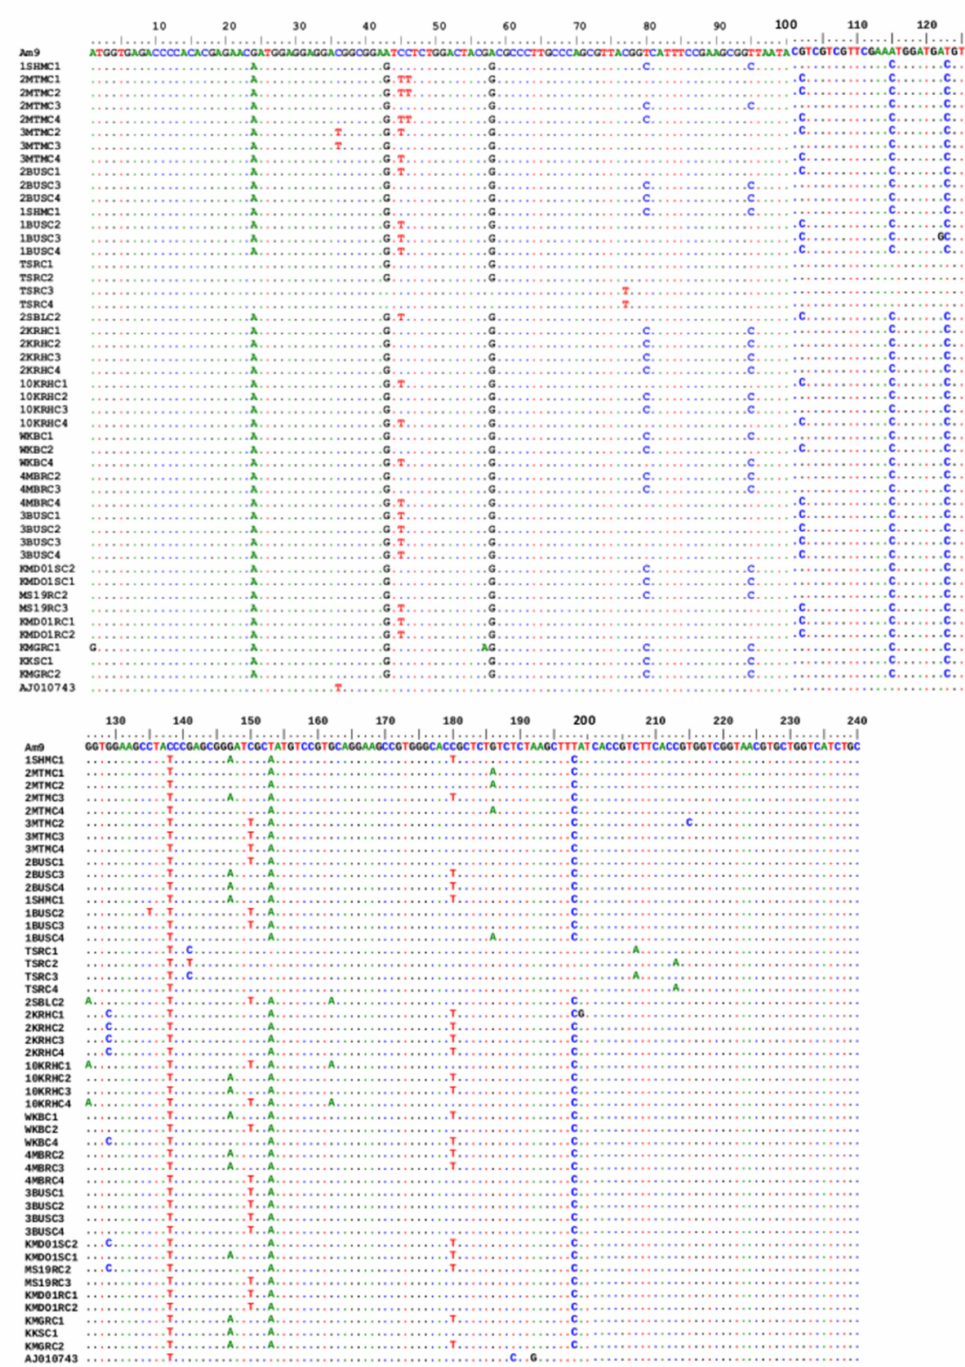
Figure 3. Multiple sequence analysis of 231 bp R. ( B .) decoloratus OCT/Tyr receptor gene partial coding region in amitraz-resistant and -susceptible ticks. AJ010743, octopamine-like, G-protein coupled receptor from R. ( B .) microplus strain from Australia. A total of 47 sequences were generated in this study. Amitraz resistance was associated with SNPs at loci A1G, C46T A122G and T215C. AM9 to KMGRC2 identifies different clones of the OCT/Tyr gene from various tick populations